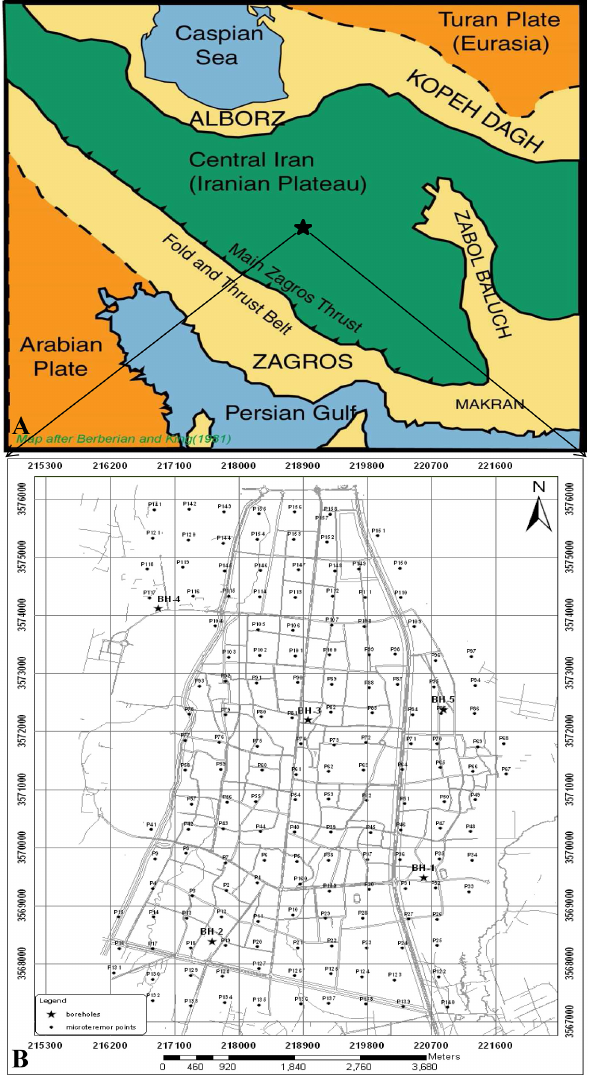
Figure 1. (a) Location of the study area (black star) in Iran; (b) map of the microtremor recording points and boreholes.